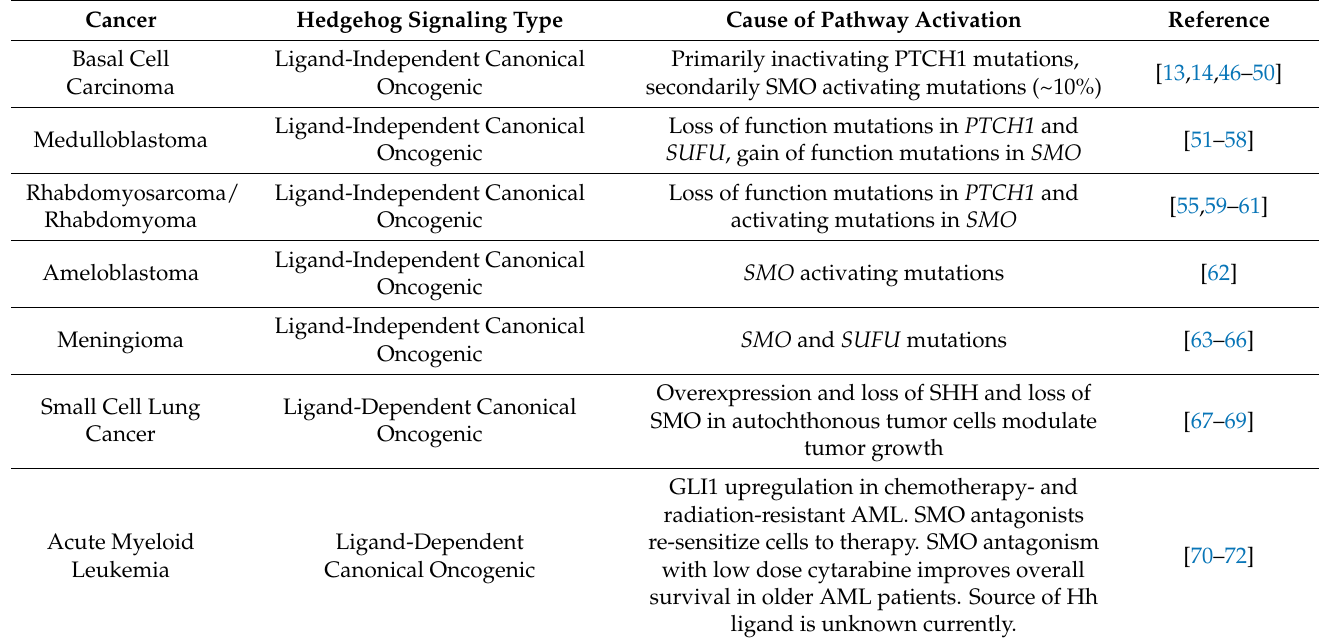
Table 1. List of cancers with canonical Hh pathway